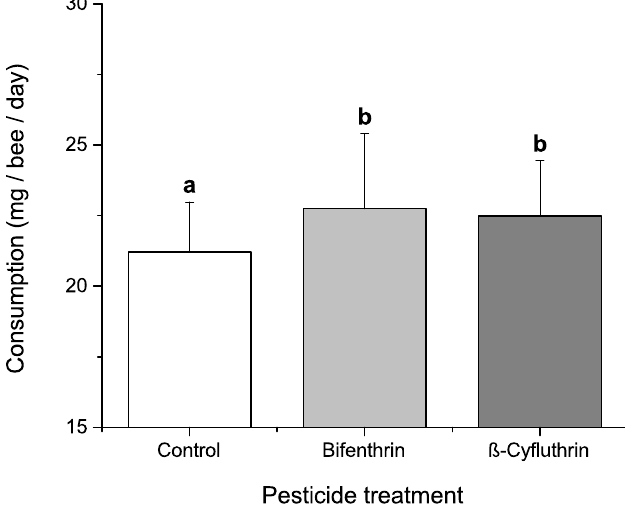
Figure 4. Mean + SD milligrams syrup diet consumption per bee per day over entire adult lifespan in cages containing different pesticide treatments. Different lower-case letters indicate significant differences (Kruskal-Wallis ANOVA, χ 2 = 10.255, p = 0.006; post-hoc comparisons by Mann-Whitney U -test with Bonferroni correction, adjusted alpha = 0.017).